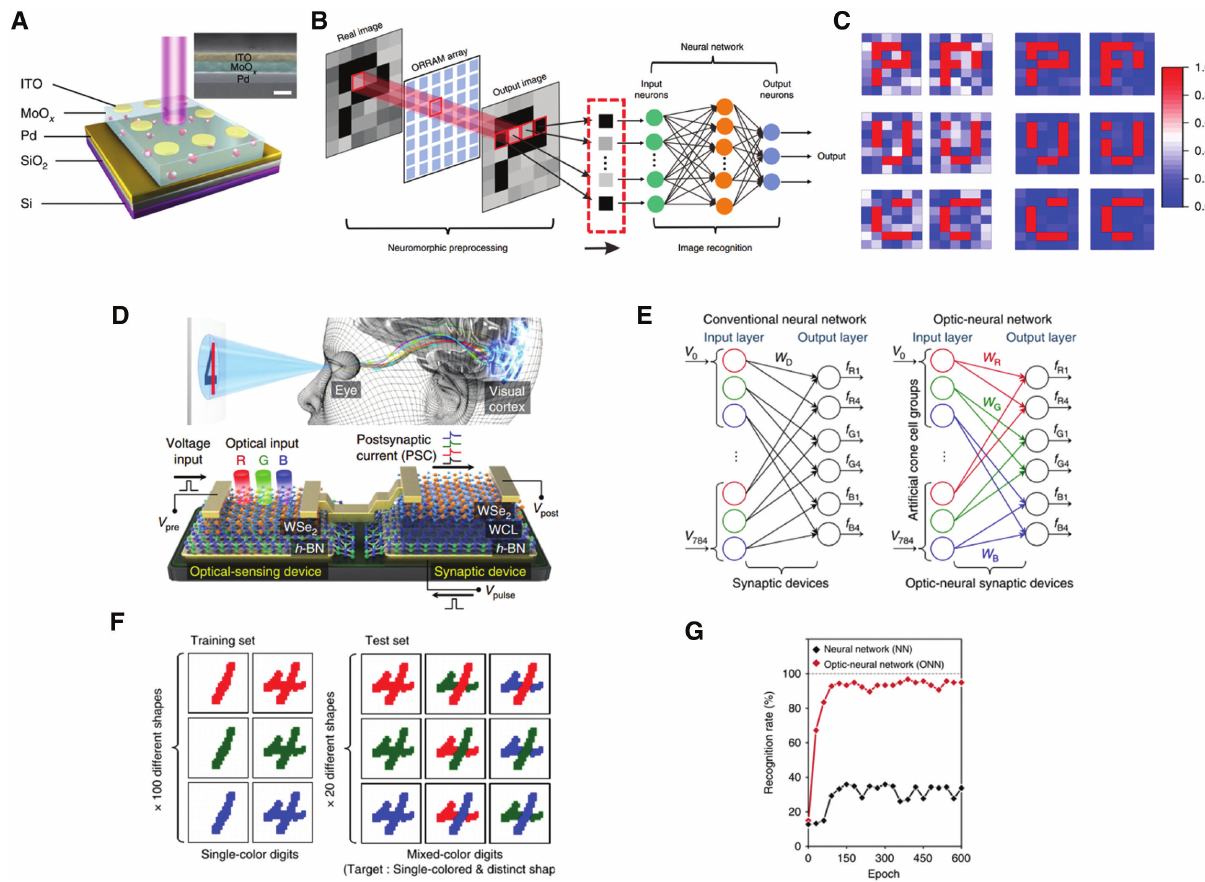
Figure 9: The application of photonic memristor arrays in pattern classification. (A) Schematic structure of a MoO photonic memristor. (B) Illustration of an artificial neuromorphic visual system based on the ORRAM x